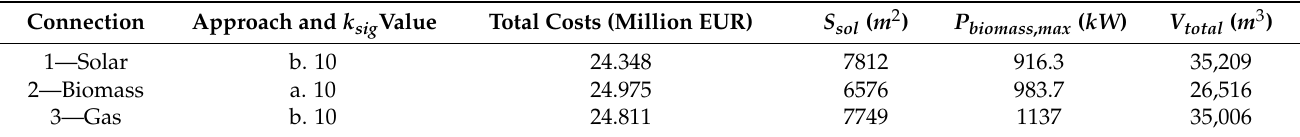
Table 3. Optimal configuration for each connection studied.